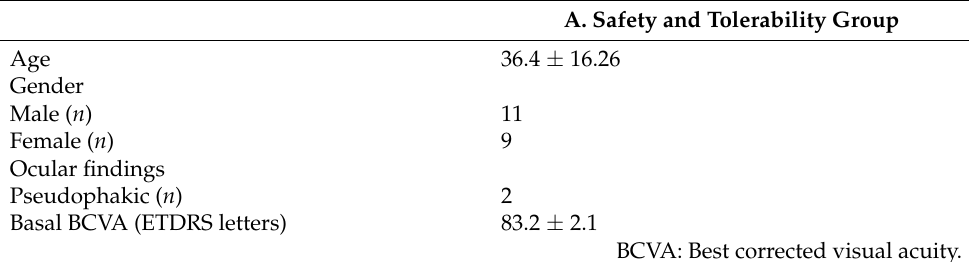
Table 2. Demographic and clinical characteristics of patients and study eyes.